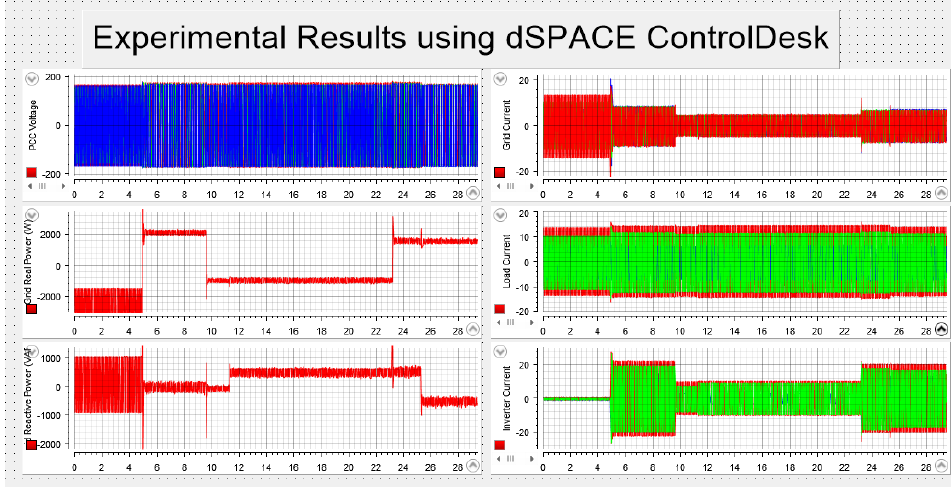
Figure 19. Experimental results overall cases, using dSPACE Control desk. Figure 20 represents the real power sent to the grid as the required value with a small error. The negative sign means the real power is delivered into the grid, while the positive sign means the real power direction is out of the grid.